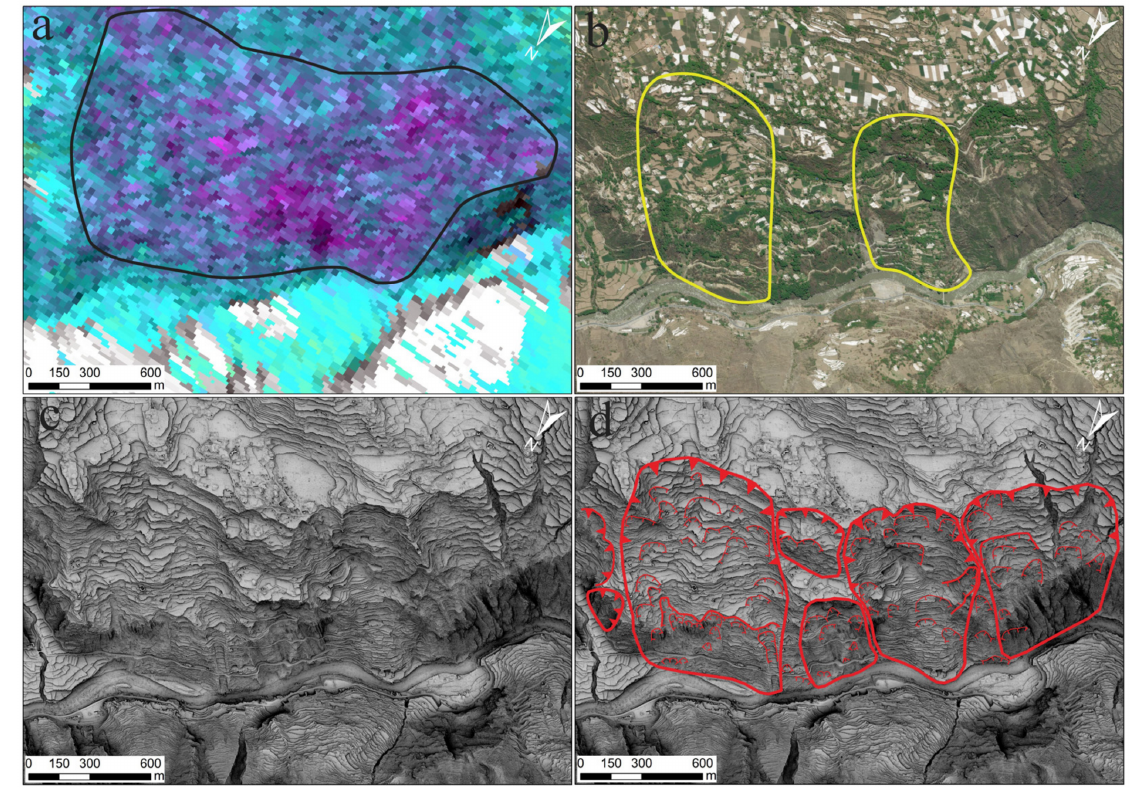
Figure 10. ( a ) Landslide boundary interpreted in the stacking InSAR differential interferogram; ( b ) landslide boundary interpreted in the satellite optical image; ( c ) LiDAR-SVF image; ( d ) landslide boundaries, ridges, and secondary sliding boundaries interpreted in the LiDAR-SVF